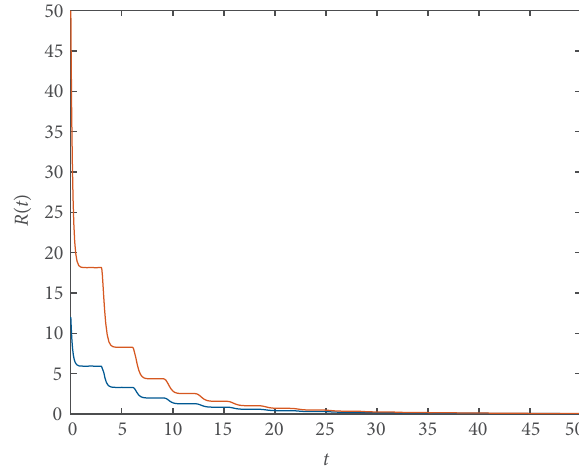
Figure 1: The curve of the function